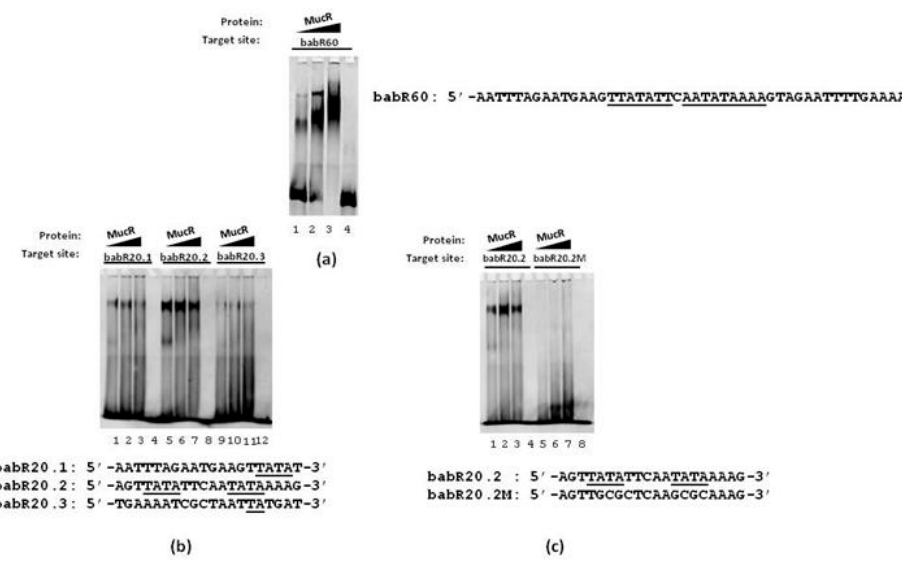
Figure 2. MucR binds the babR promoter. EMSAs of MucR with ( a ) babR60 oligonucleotide, ( b ) babR20.1, babR20.2 and babR20.3 oligonucleotides, ( c ) babR20.2 and the mutant version babR20.2M. In ( a ), ( b ) and ( c ) the growing amount of protein used is indicated on the top of the lanes and the single-stranded sequences of the double-stranded oligonucleotides tested as target sites of MucR are reported. The AT-rich regions comprising T–A steps are underlined. In panel ( a ), lane 4 shows the sample containing only babR60. In panel ( b ), lanes 4, 8 and 12 show samples containing only babR20.1, babR20.2 and babR20.3, respectively.